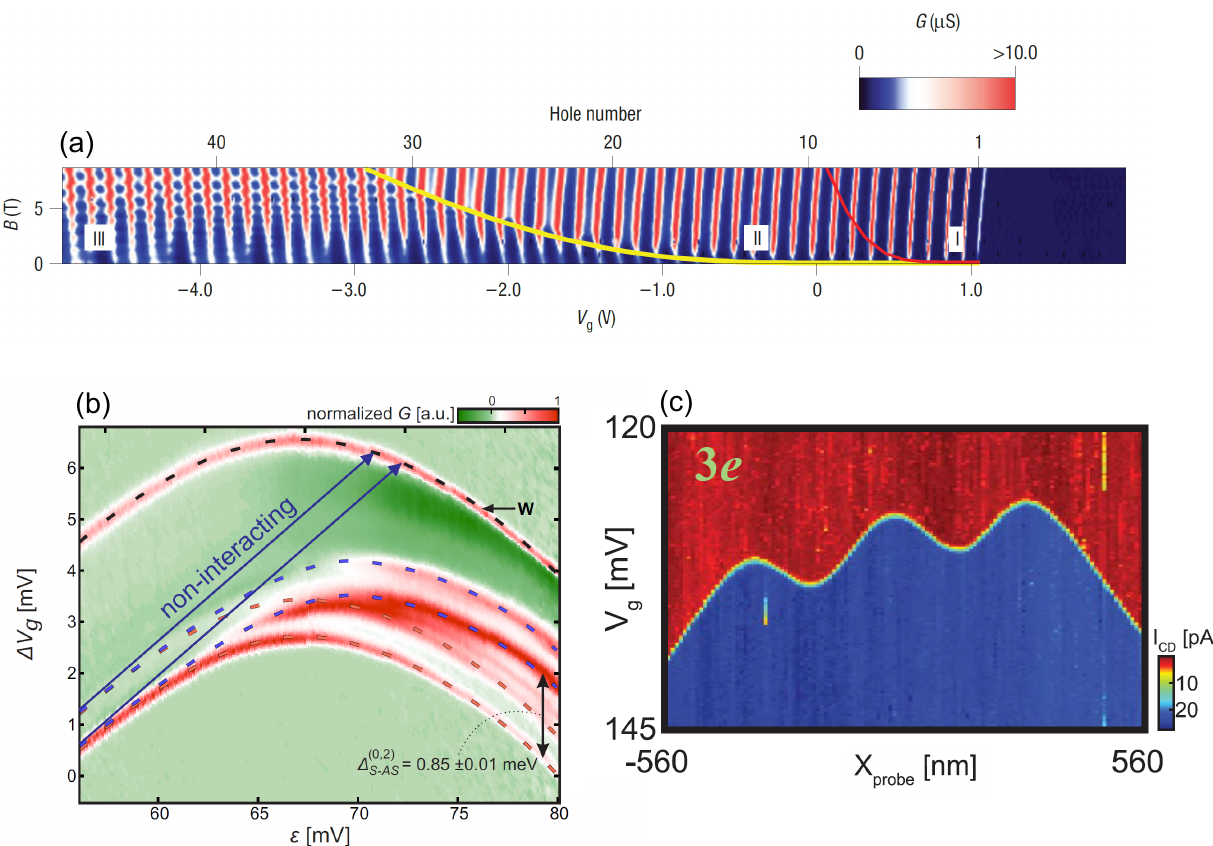
Figure 5. ( a ) Differential conductance as a function of gate voltage and magnetic field as measured in Ref. [116]. The three regions are highlighted with the red and the yellow curves. ( b ) Differential conductance as a function of gate voltage and a detuning parameter in Ref. [119]. The key aspect is here the energy scale highlighted by the black arrow, that demonstrates the suppression of the energy of the spin excitations. ( c ) Current in the control nanotube as a function of gate voltage position of the scanning nanotube for three electrons in the system as measured in [120]. The characteristic three peak structure is clearly